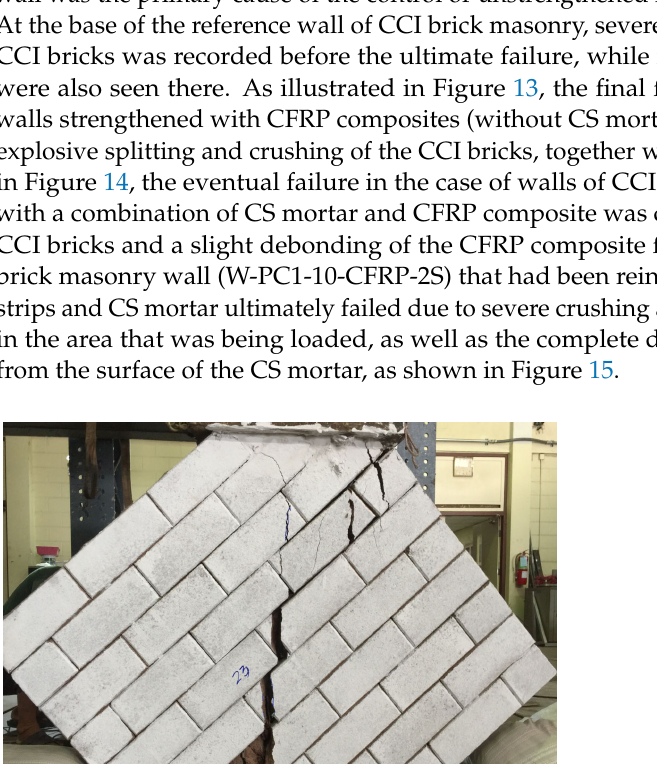
Figure 13. Failure of W ‐ CFRP ‐ 1L and W ‐ CFRP ‐ 2L walls at loads 470 and 605 kN, respectively.